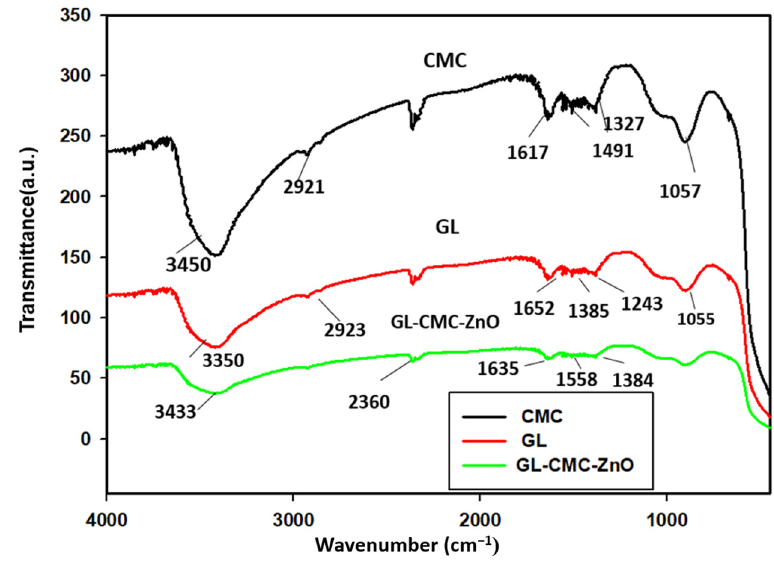
Figure 5. FTIR spectra of GL–CMC–ZnO NCs (green line), CMC (black line), and ginseng leaves extracts (red line).